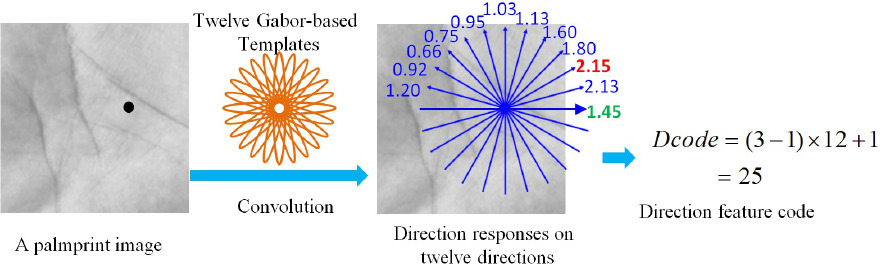
Figure 4. The basic procedure of direction feature code calculation of a palmprint image. We first define twelve direction feature templates based on Gabor filters with different directions. Then, we convolve these templates with the palmprint image to calculate the direction responses of twelve directions. Finally, we encode the direction with the maximum direction response and the maximum direction response interval into the direction feature